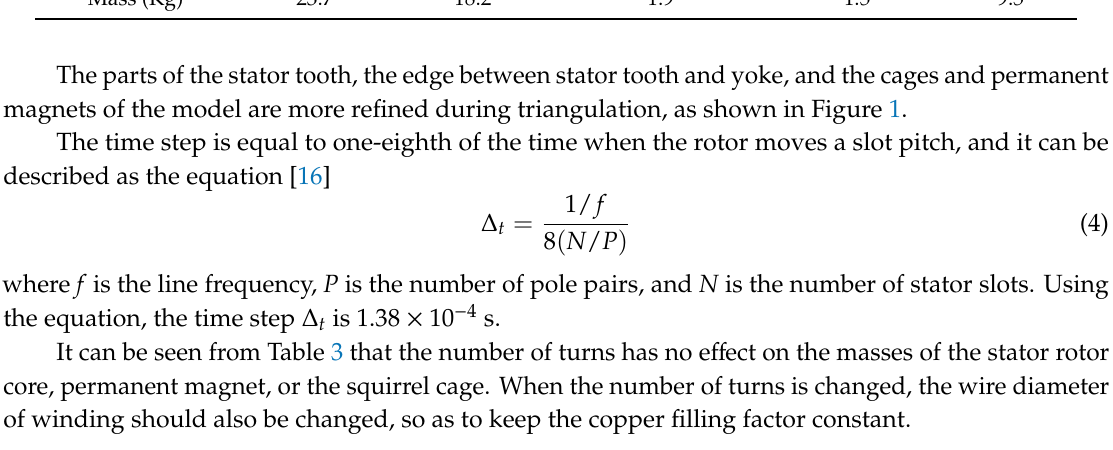
Table 3. Material masses of each component of the motor.